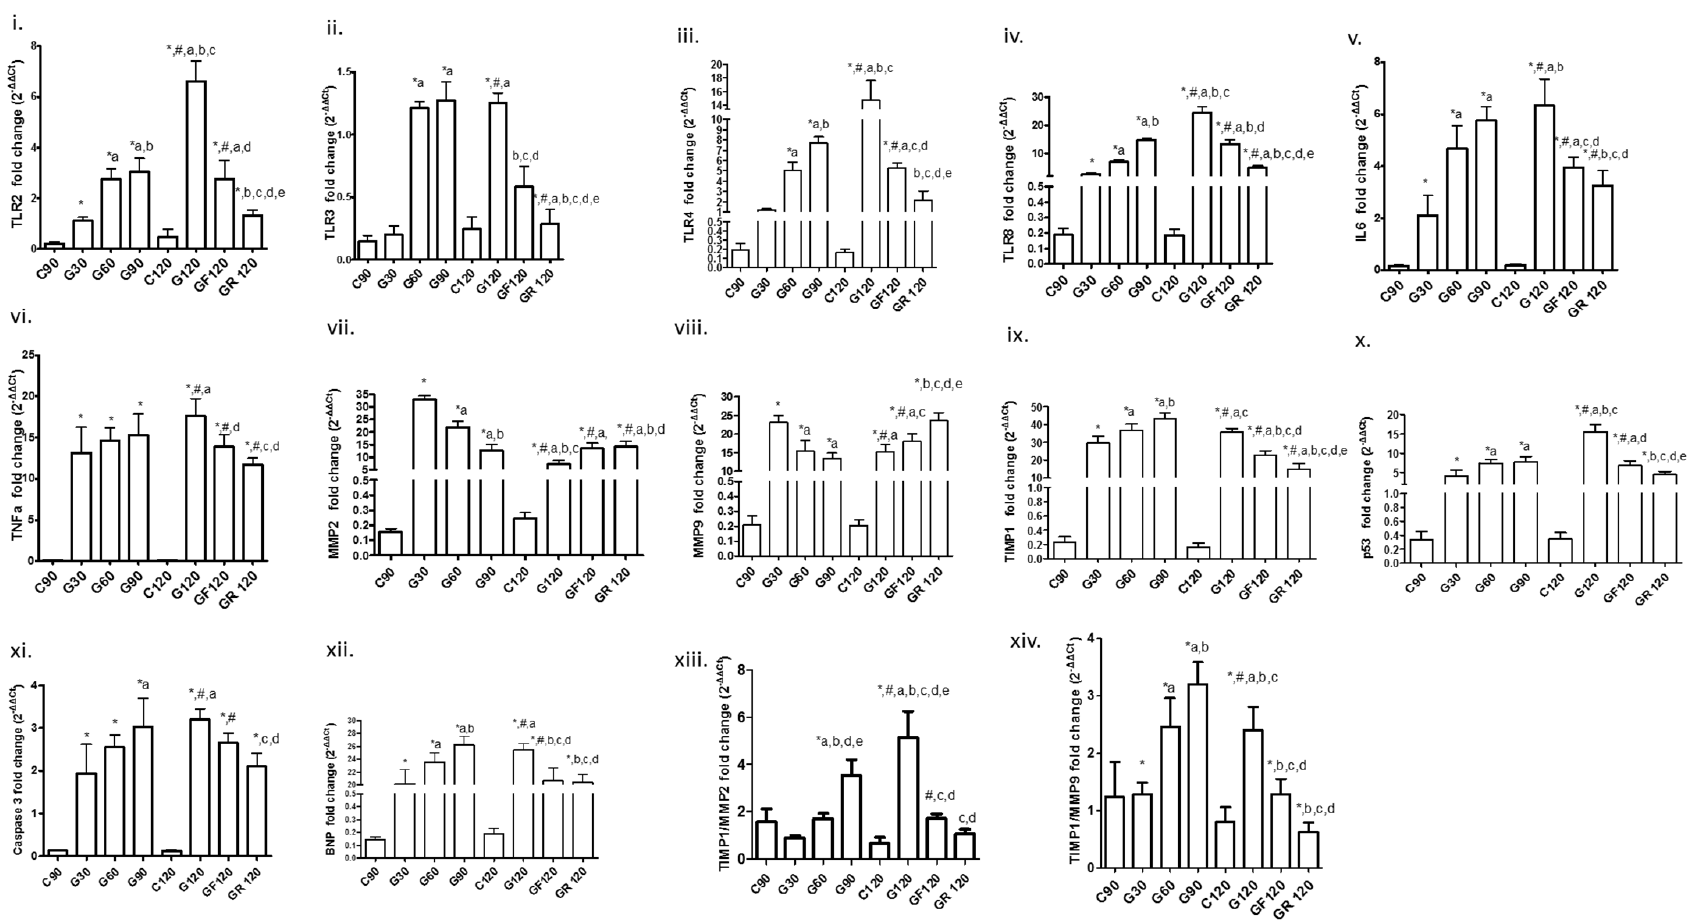
Figure 1. mRNA expression of biomarkers. TLRs 2 ( i ), 3( ii ), 4 ( iii ) and 8 ( iv ); IL6 ( v ); TNFa ( vi ); MMPs 2 and 9 ( vii , viii ); TIMP1 ( ix ); p53 ( x ); CASP3 ( xi ); BNP ( xii ); ratio TIMP1/MMP2 ( xiii ); and ratio TIMP1/MMP9 ( xiv ) in myocardium. Significant difference ( p < 0.05) versus C90 (*), C120 (#), G30 (a), G60 (b), G90 (c), G120 (d), GF120 (e).